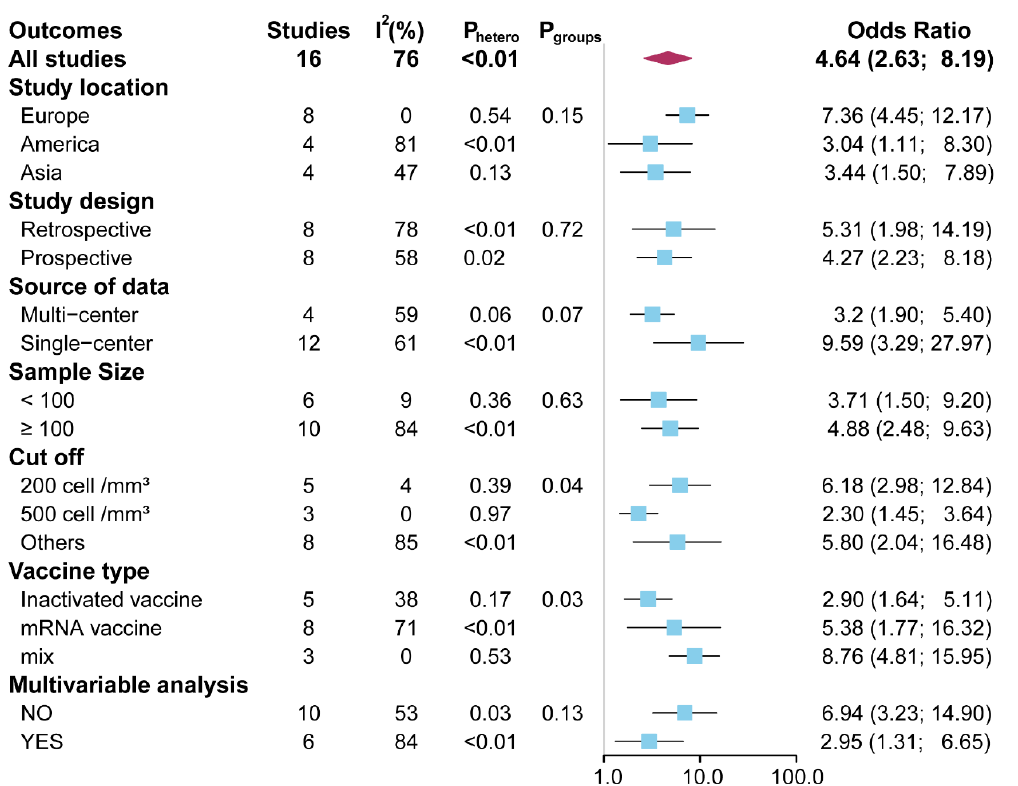
Figure 3. The pooled odds ratio of CD4 T-cell counts in subgroup analyses.